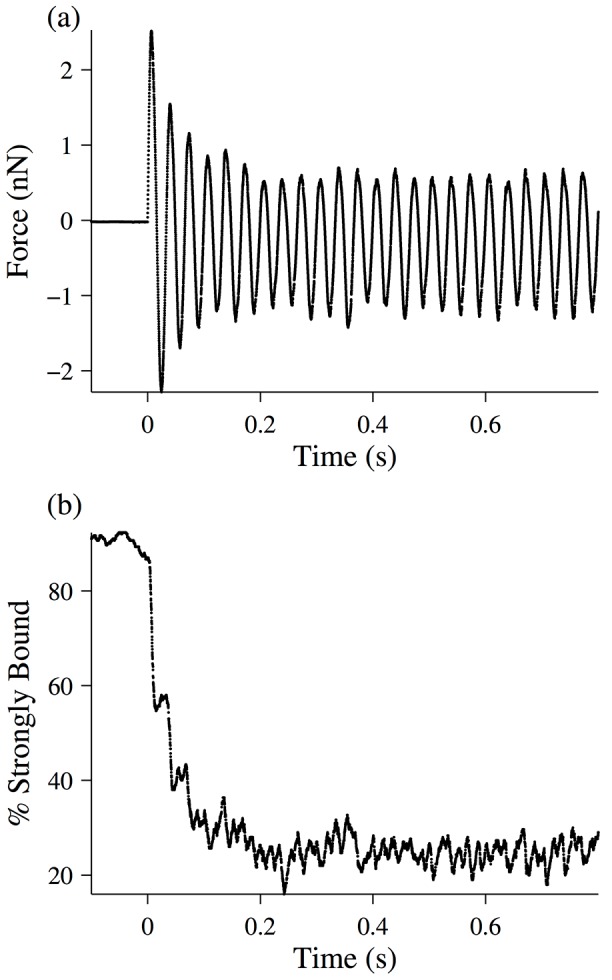
Simulation of a half-sarcomere experiencing a 30 Hz length oscillation.The simulation is described in detail in the text, and the parameters used are found in Table 1. (a) Force-response time-trace of the half-sarcomere. (b) Percent of strongly bound cross-bridges (i.e. in one of the attached states) as a function of time.